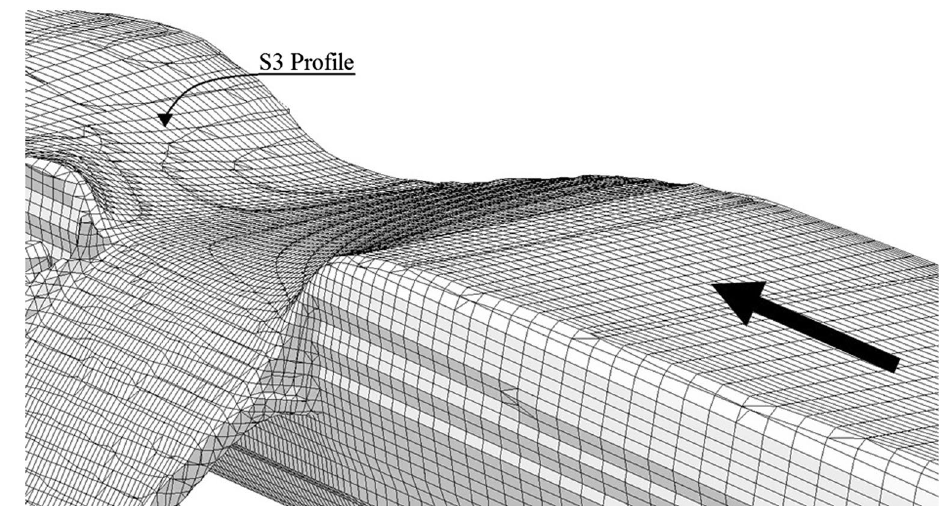
Fig. 9 3D view of flow